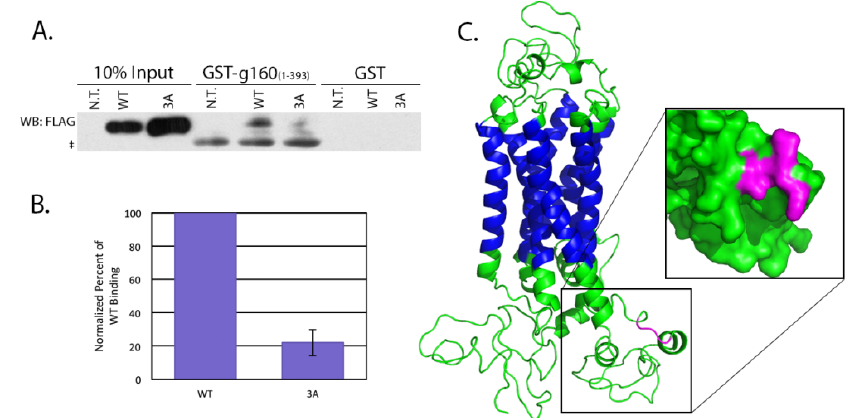
Figure 3. Full length β 1AR interacts with golgin-160 in a KRR-dependent manner. (1–393) ( A ) HeLa cells were either not transfected (N.T.) or transiently transfected with constructs encoding FLAG- β 1AR WT or 3A. Lysates were prepared at 18 h post-transfection and -conjugated glutathione-Sepharose beads. incubated with GST- or GST-golgin-160 (1–393) Bound β 1AR was detected by anti-FLAG immunoblotting. g160, golgin-160. The ‡ indicates nonspecific binding of the antibody to the GST-golgin-160 fusion protein; ( B ) Quantification of binding after normalization to input, n = 7, p = 1.9 × 10 − 7 . Error bars represent standard deviation; ( C ) Structural model of human β 1AR with an expanded region showing the surface filling model of intracellular loop 3. The KRR sequence is shown in magenta, the transmembrane regions are in blue. Structure prediction was performed using Phyre2 and modeled using